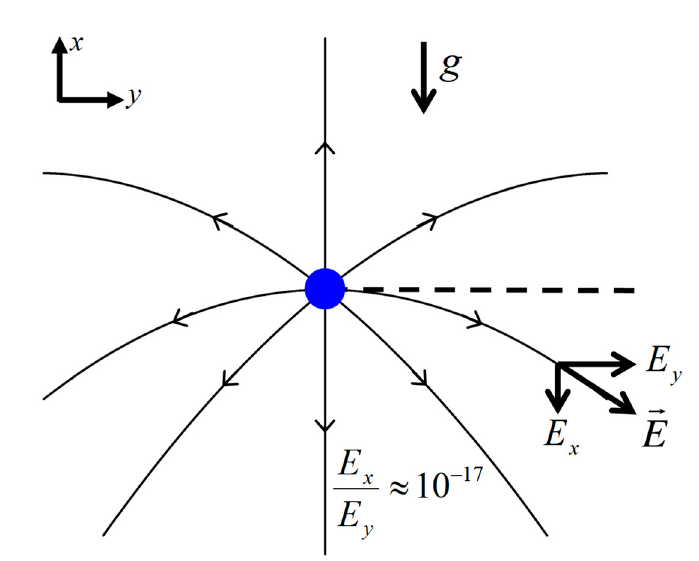
Figure 2. Gravitationally-distorted Coulomb field of a point charge (blue point). The straight, black, dotted line indicates a horizontal field line when there is no gravity. The solid field lines are curved due to the presence of a vertical downward gravitational field (cid:1859) (cid:3404) 9.8 m/s (cid:2870) . At a horizontal distance of 10 cm (typical for table top experiments), the vertical component of the electric field (cid:1831) is smaller than the horizontal component (cid:1831) by a (cid:3051) (cid:3052) factor of 10 (cid:2869)(cid:2875)